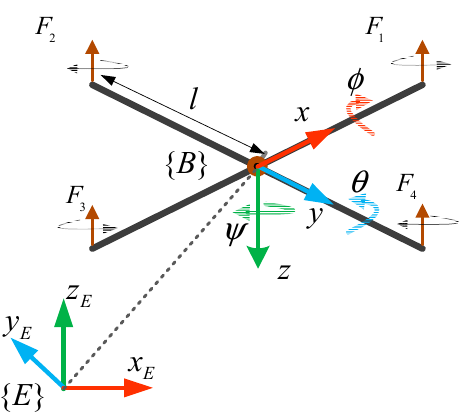
Figure 1. Quadcopter configuration.